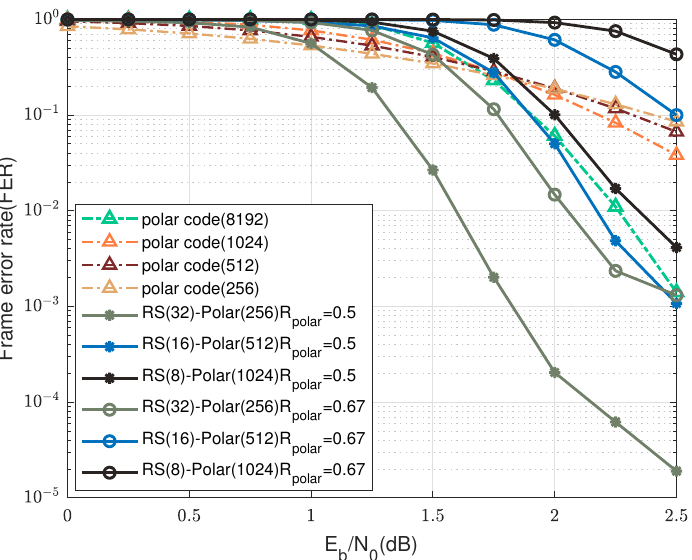
Figure 13. Comparison between the UEP-RS-polar product codes and the SC decoding of single polar codewords over GE channels for R tx ≈ 1/3, P GG = 0.9 and R polar = 0.5,